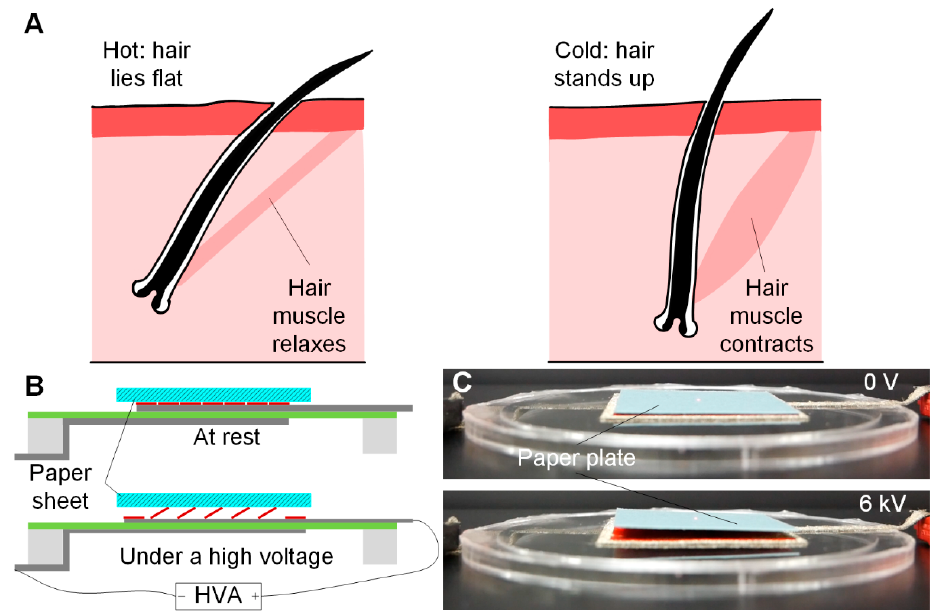
Figure 7. Bio-inspired e-textile DEA driven skin thermal regulation device working principle and prototypes. ( A ) Schematic diagram of the hair thermal regulation principle. ( B ) Schematic diagram of